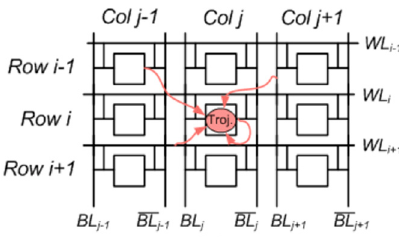
Figure 5. Hardware Trojan insertion in SRAM (Static Random Access Memory) array [22].